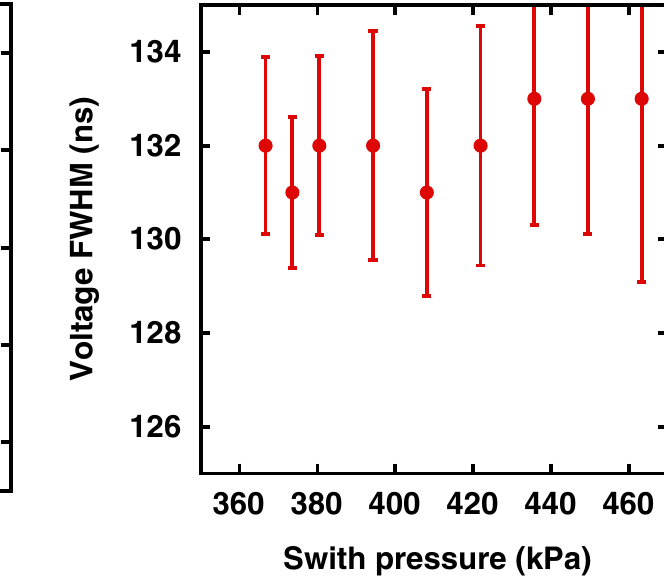
FIG. 16. (Color) Average pulse rise time as a function of switch pressure. The error bars represent the shot to shot statistical variation ( 1 (cid:2) ).